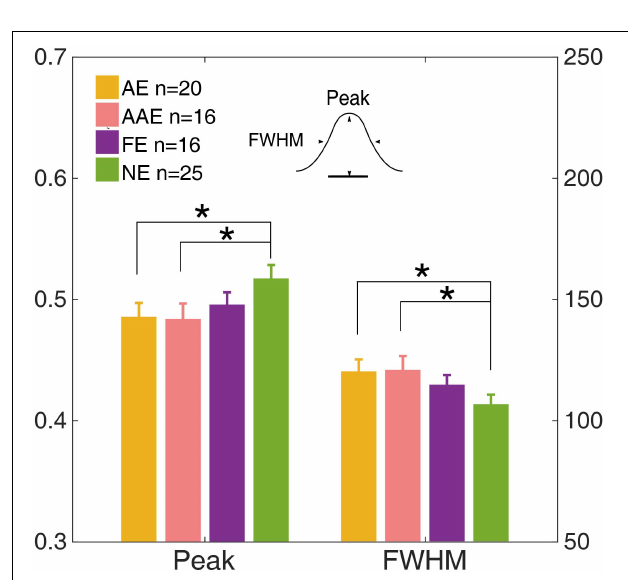
FIGURE 6 | The peak and full width at half maximum (FWHM) of the temporal window of the AE (yellow), AAE (pink), FE (purple), and NE (green). The left y -axis shows the peak and the right y -axis shows the FWHM. Error bar : ± 1 standard error. *: p < 0.05.